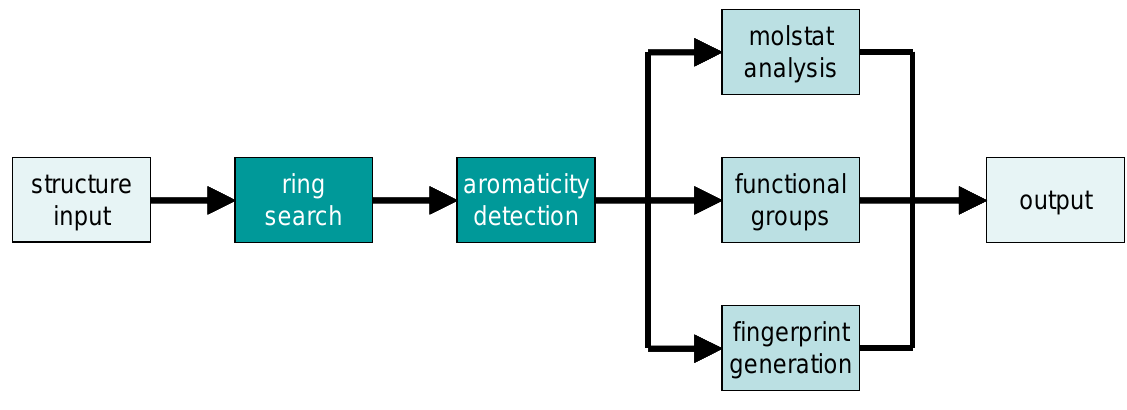
Figure 2. Main workflow for analysis of a chemical strucure by the checkmol